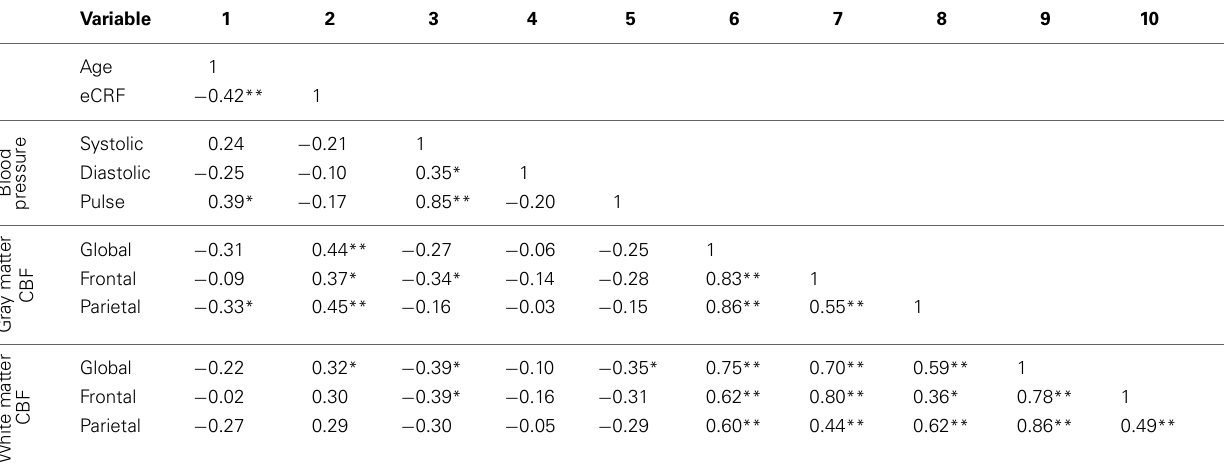
Table 3 | Partial correlations between age, eCRF, blood pressure, and CBF, controlling for gender. Variable